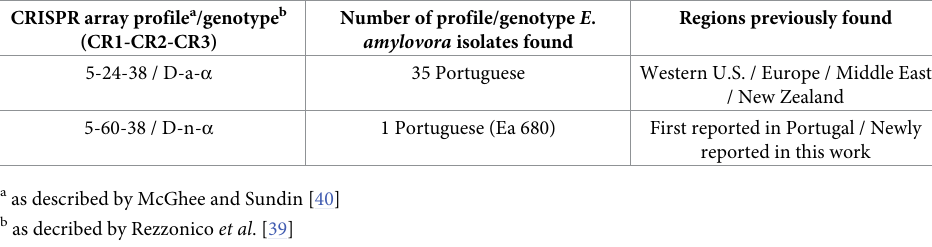
Table 4. CRISPR array profile/genotype found in Erwinia amylovora